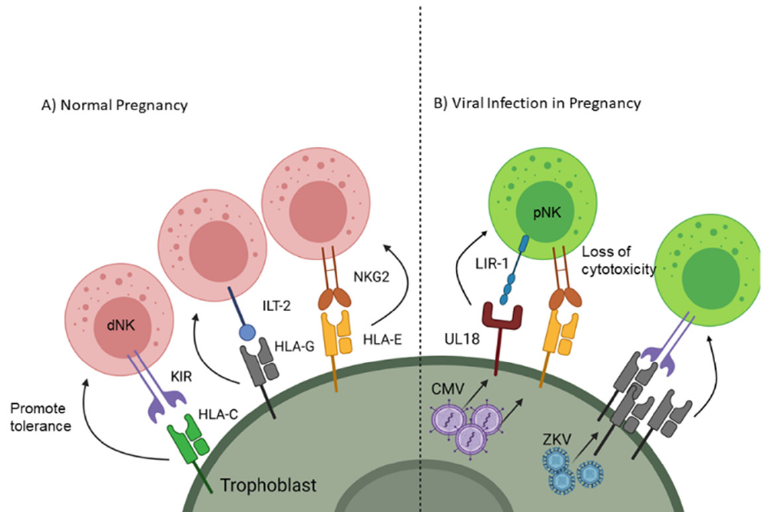
Figure 1. Receptor signaling on trophoblast cells to promote natural killer (NK) cell tolerance to the fetus and viruses. ( A ) Non-classical MHC interactions with NK cells promotes decidual (d)NK phenotype and tolerance. ( B ) Overexpression of non-classical MHC and upregulation of decoy receptors are used by viruses (CMV and Zika virus (ZKV)) to blunt peripheral (p)NK cytotoxicity. Created with BioRender.com. Accessed on 6 February 2021